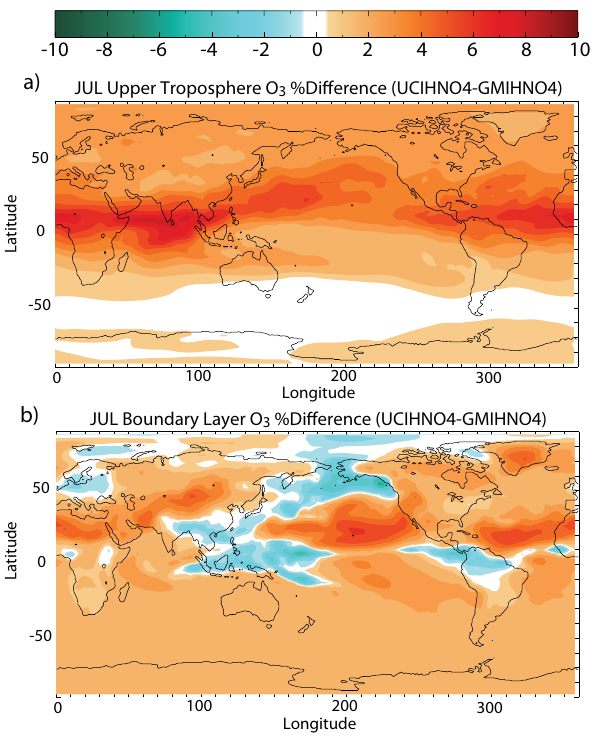
Fig. 8. (a) Latitude-longitude cross section of the percent differ- ence between UCI-HNO4 and GMI-HNO4 O 3 averaged over the upper troposphere (150hPa <p < 500hPa) for July. Contour range is − 10 to 10%. (b) Same as (a) , but O 3 is averaged over the bound- ary layer ( p > 850hPa).